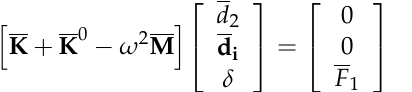
0 where K , K and M are the stiffness matrix, geometric stiffness matrix and mass matrix of the CLPF, respectively; d i is the nodal displacement amplitude vector of interior nodes of the CLPF and d 2 is the nodal displacement amplitude of top boundary, respectively; F 1 is the nodal load force amplitude of bottom boundary of the CLPF. d i , d 2 and F 1 can be obtained from Equation (7) for specified excitation angular frequency ω and excitation amplitude δ